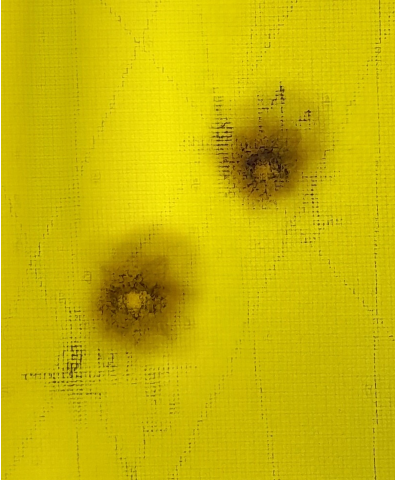
Figure 5. Impact damage introduced in the composite